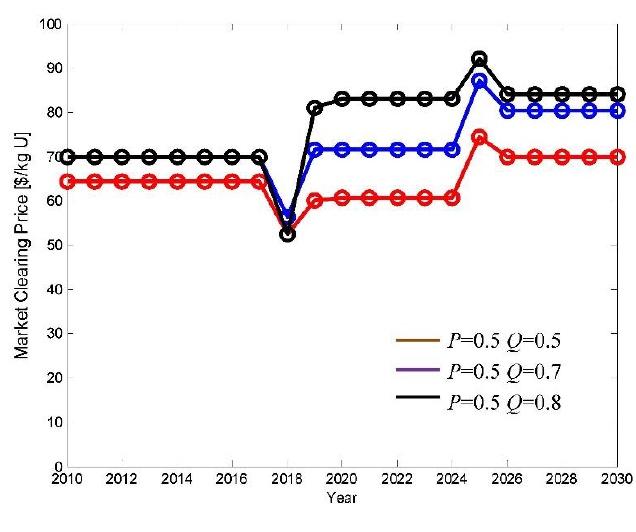
Figure 7. Market clearing